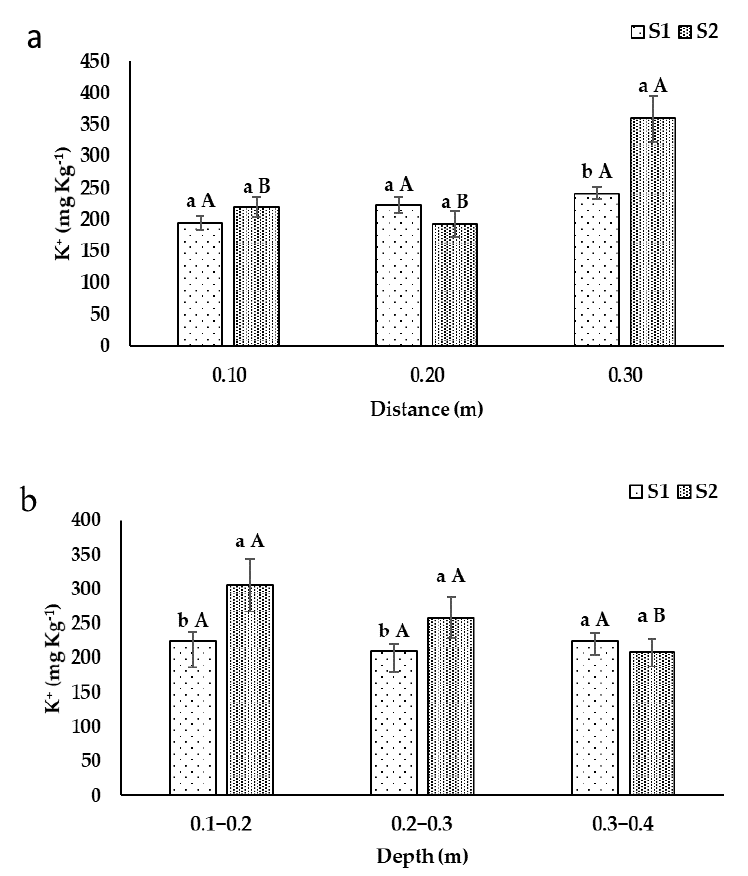
Figure 4. Interaction between distance (0.10, 0.20 and 0.30 m) and soil type (soils S 1 and S 2 ) ( a ) and depth (0.1 – 0.2, 0.2 – 0.3 and 0.3 – 0.4 m) and soil type (soils S 1 and S 2 ) ( b ) for soil K concentration (mg kg −1 ). ( a ) Lowercase letters are used for the comparison between the soil type in each distance from the emitter and uppercase letters are used for the comparison between each type of soil and distance from the emitter, ( b ) lowercase letters are used for the comparison between the soil type in each depth and uppercase letters are used for the comparison between each type of soil and depth.